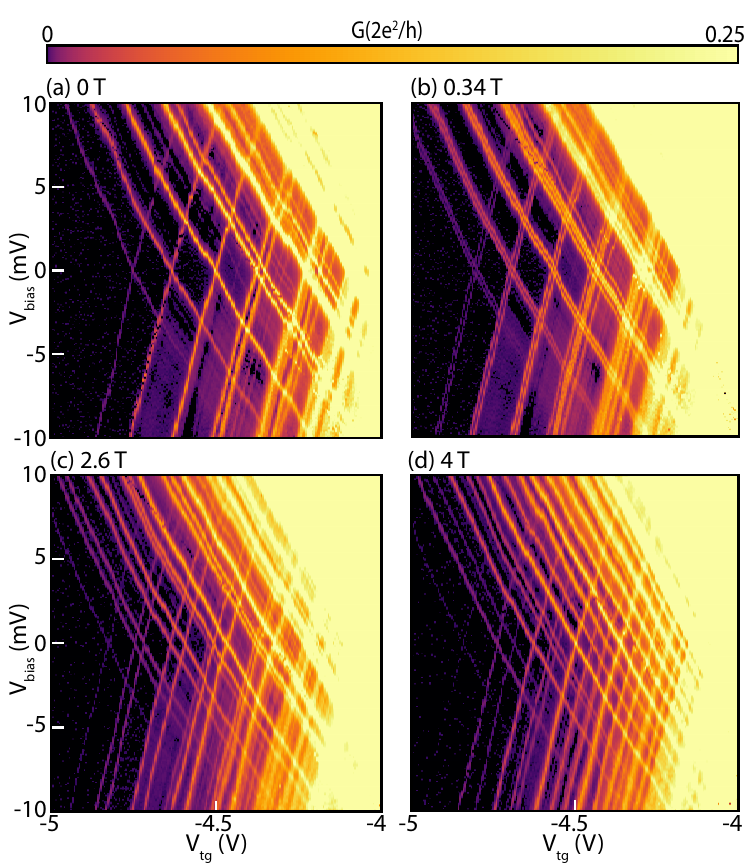
Figure 2: Differential conductance of device 1 as a function of V ferent magnetic fields for V